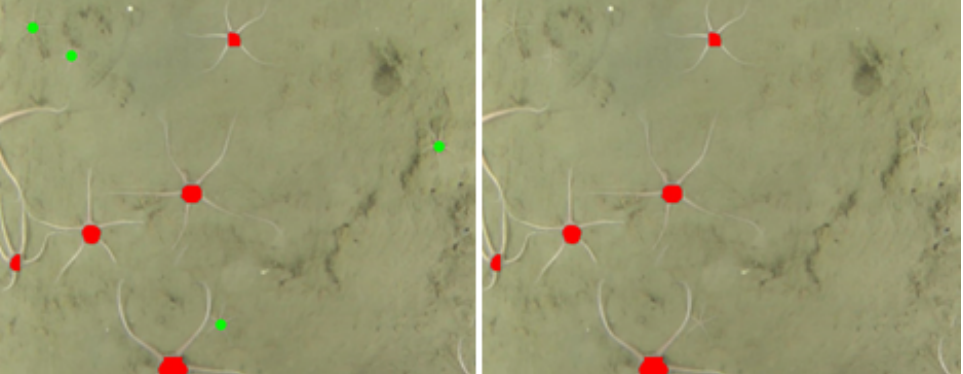
Figure 8. Example of false negative prediction from the model: organisms with hardly visible disk, marked in green color ( left hand side ), were missing in the prediction result ( right hand side ).